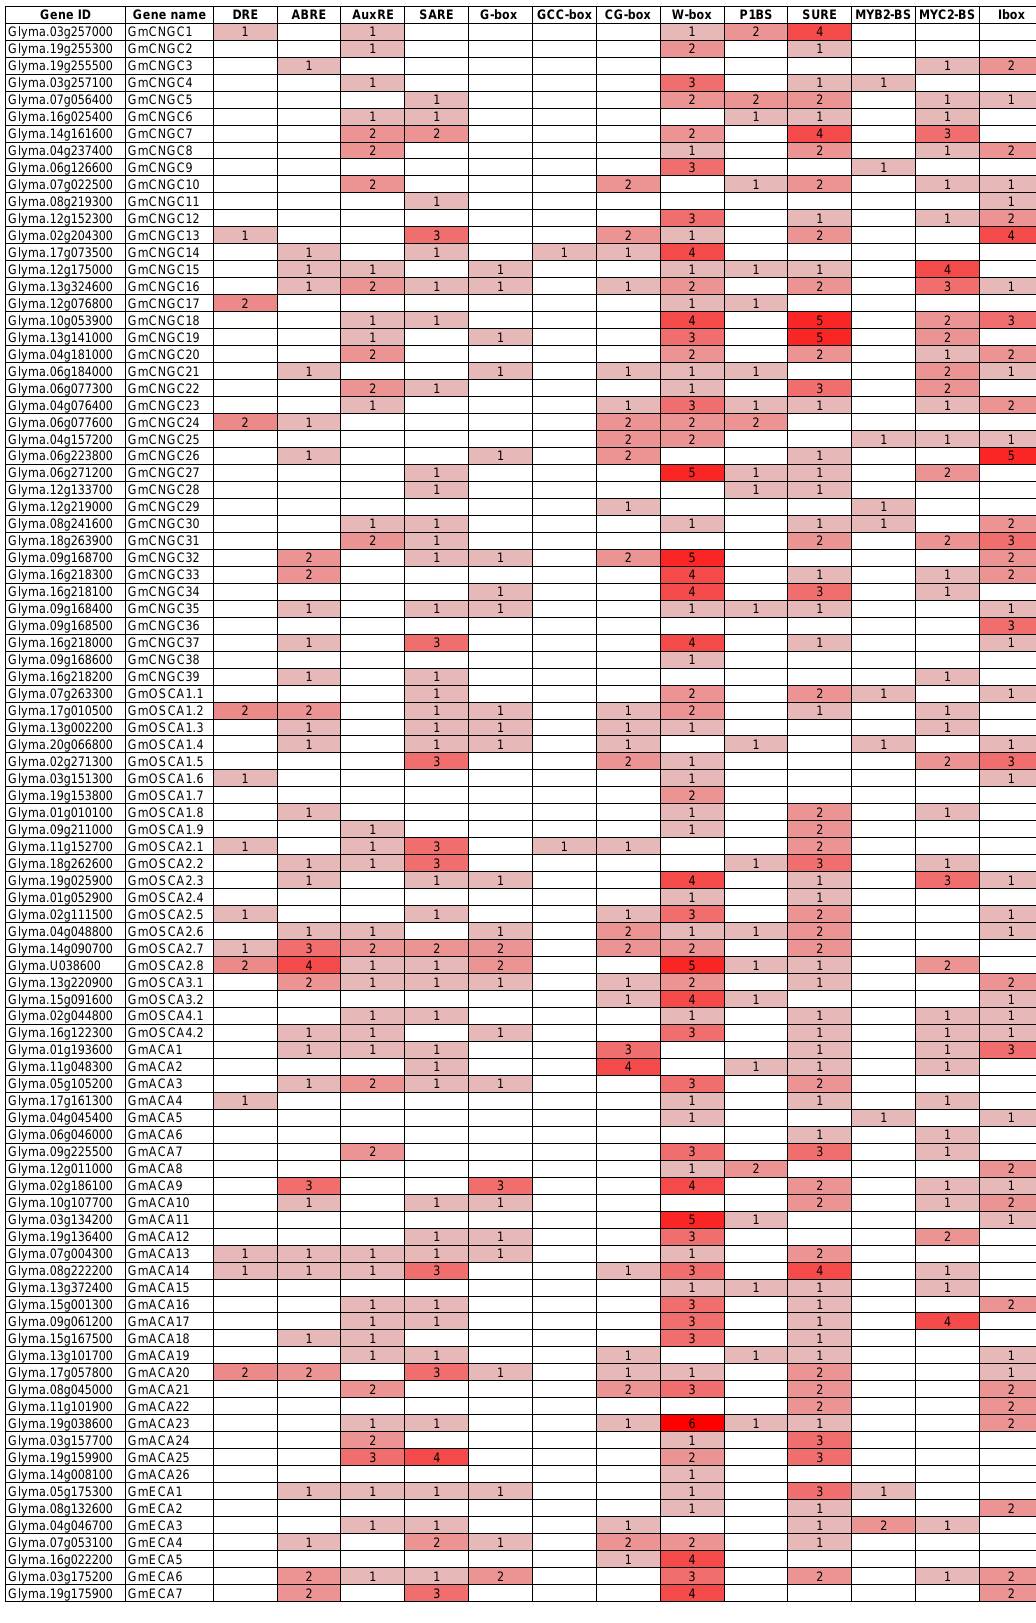
Figure 14. The distribution of cis-elements in the promoters of soybean CNGC, OSCA, and Ca 2+ -ATPase gene families. The intensities of the color represent the number of cis-elements.